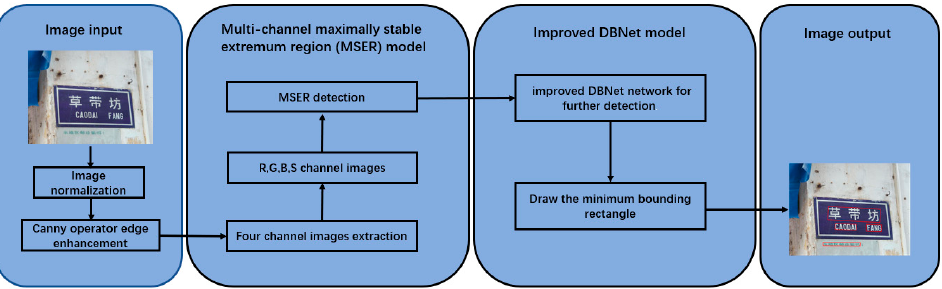
Figure 1. Overall flow chart of the method proposed in this paper